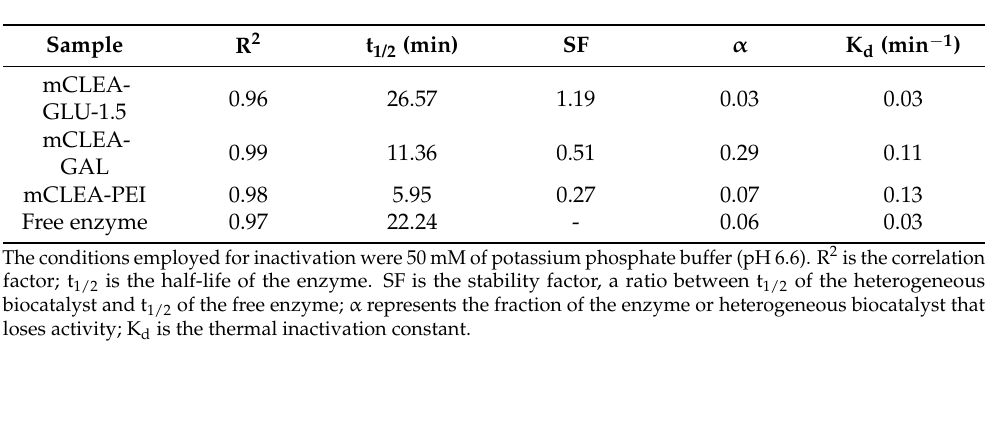
Table 4. Sadana and Henley model parameters for thermal inactivation at 60 ◦ C of free enzyme and magnetic β -galactosidase CLEA biocatalysts produced with an inhibitor or subsequent coating with